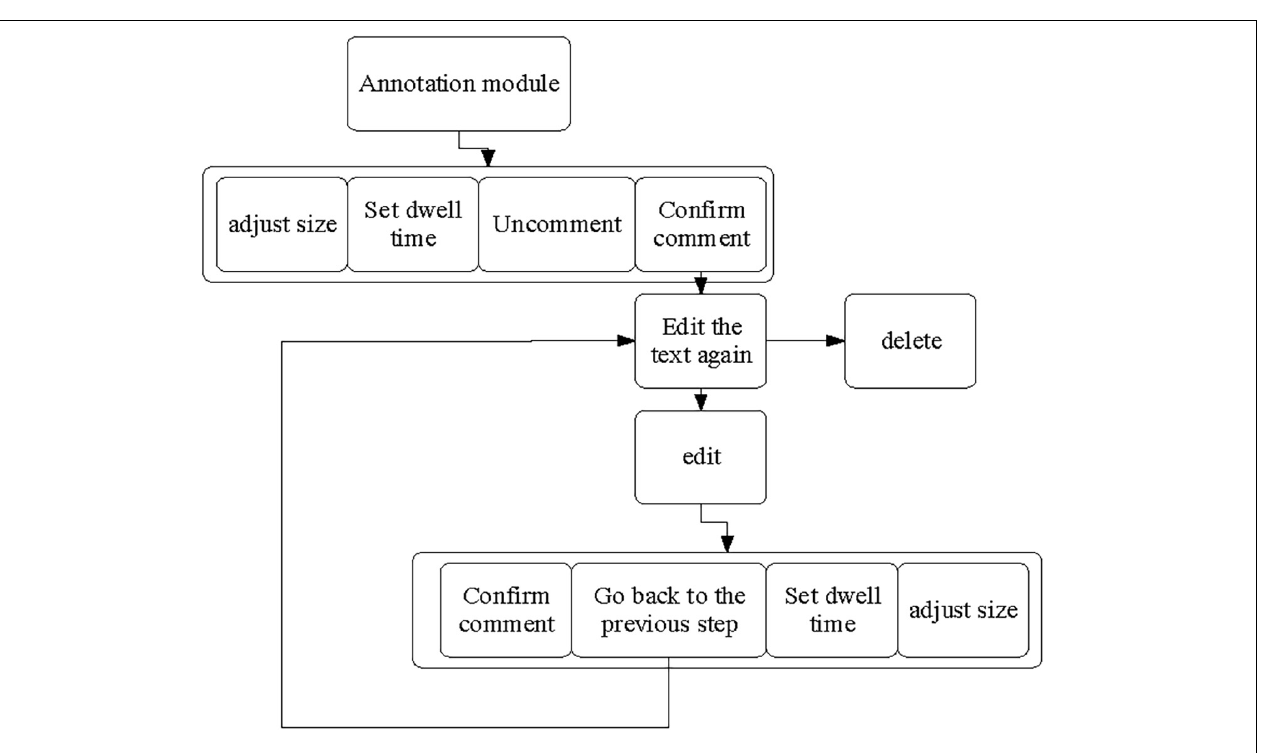
FIGURE 4 | Logical structure of video annotation interactive